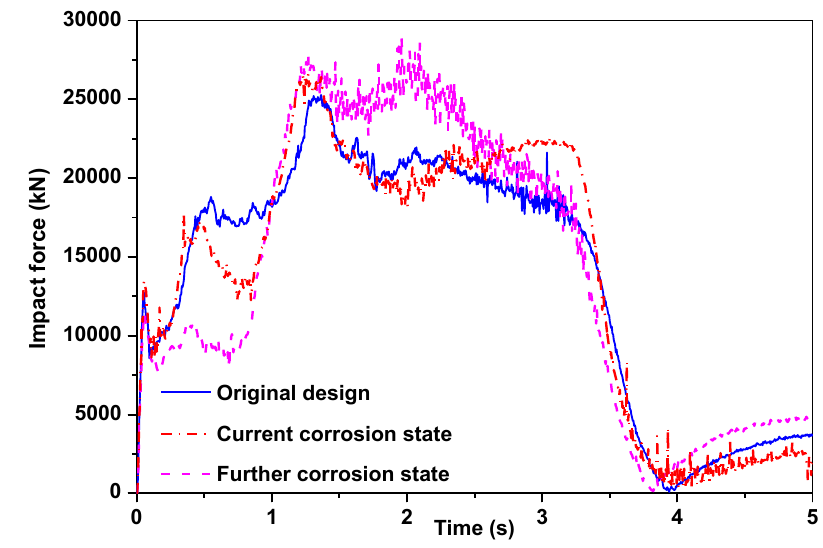
Figure 6. Reaction force histories of the bridge pier under different corrosion